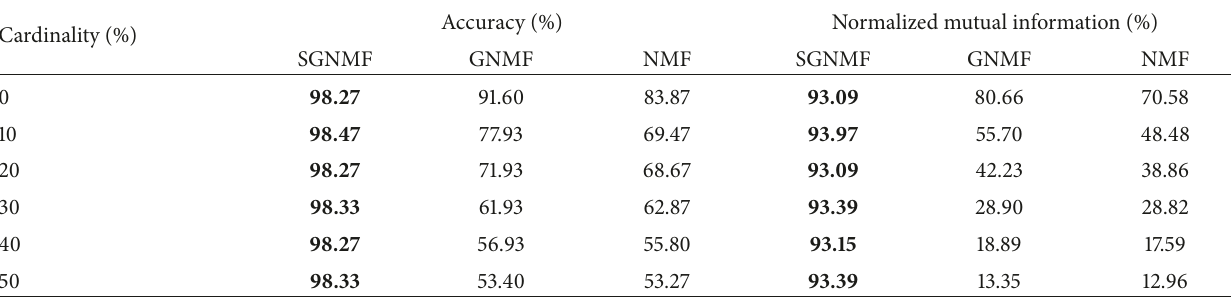
Table 7: Clustering performance on IRIS in case 1 .